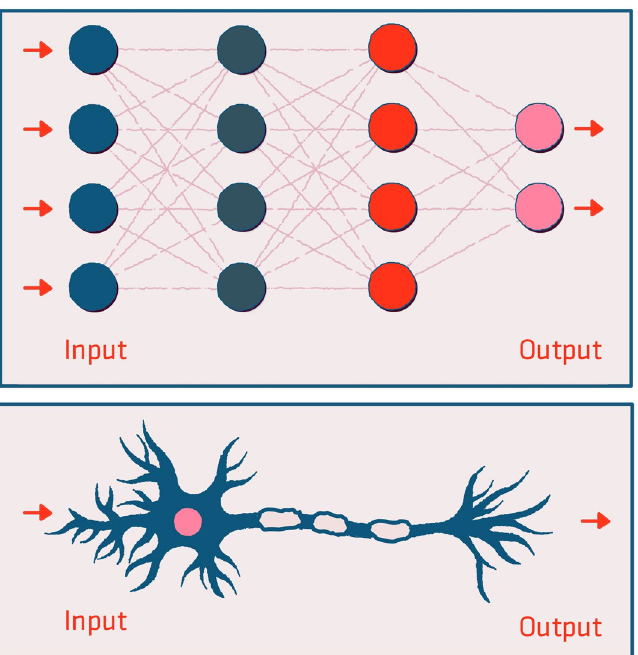
Figure 2. Comparison between artificial and biologic neural networks. Neural networks are comprised of multiple interconnected layers. Data is fed to the network, and an output is produced. By comparing the network’s output to the desired true label, an error can be estimated. Based on the error, the algorithm optimizes connections between the layers. The connections between the neurons are termed “weights”. Ultimately, a tuned network is